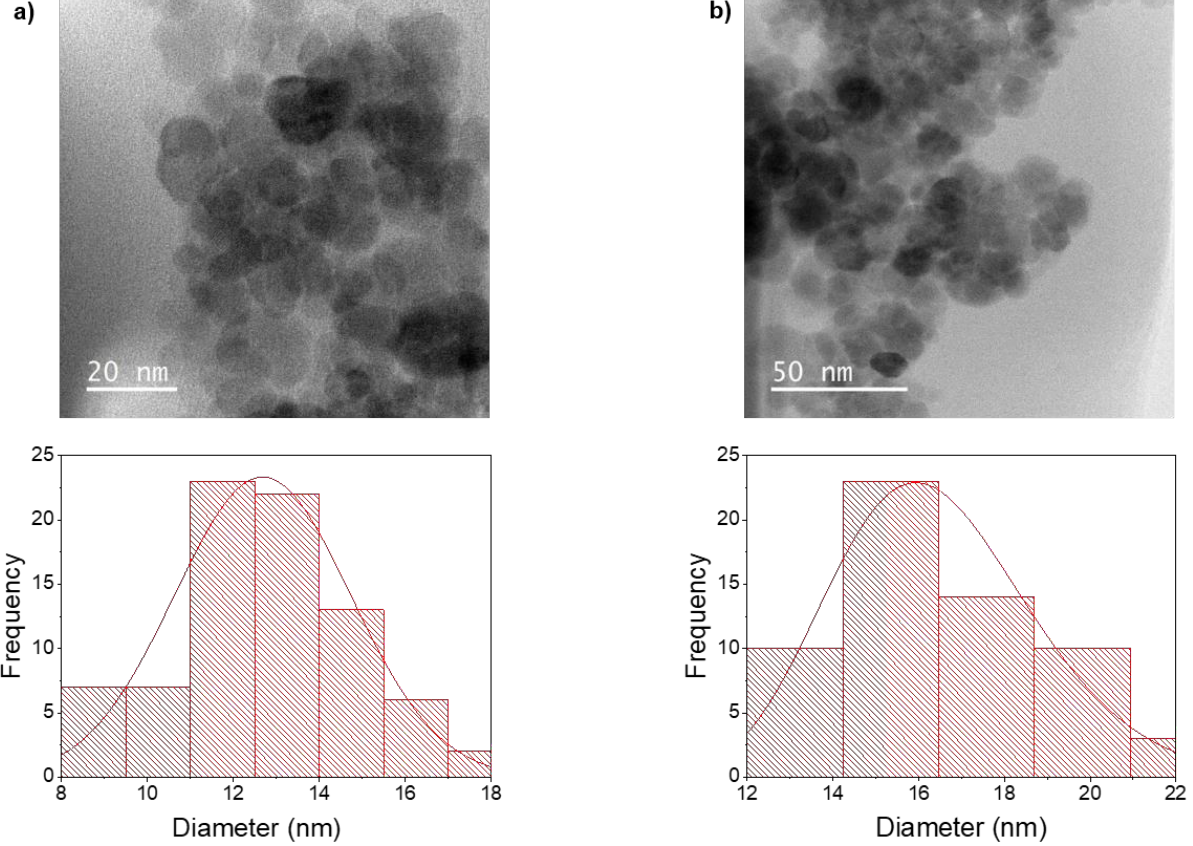
Figure 4. Microscopy images of ( a ) Fe 3 O 4 @citrate and ( b ) Fe 3 O 4 @APTES with the corresponding his- tograms.